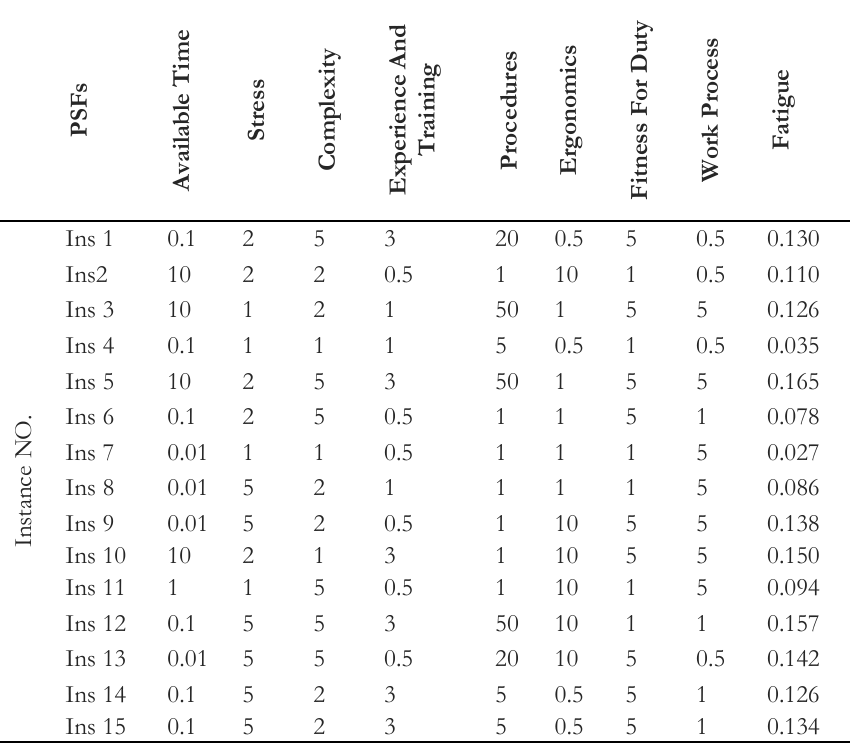
Table 3. The PSFs value for each instance.